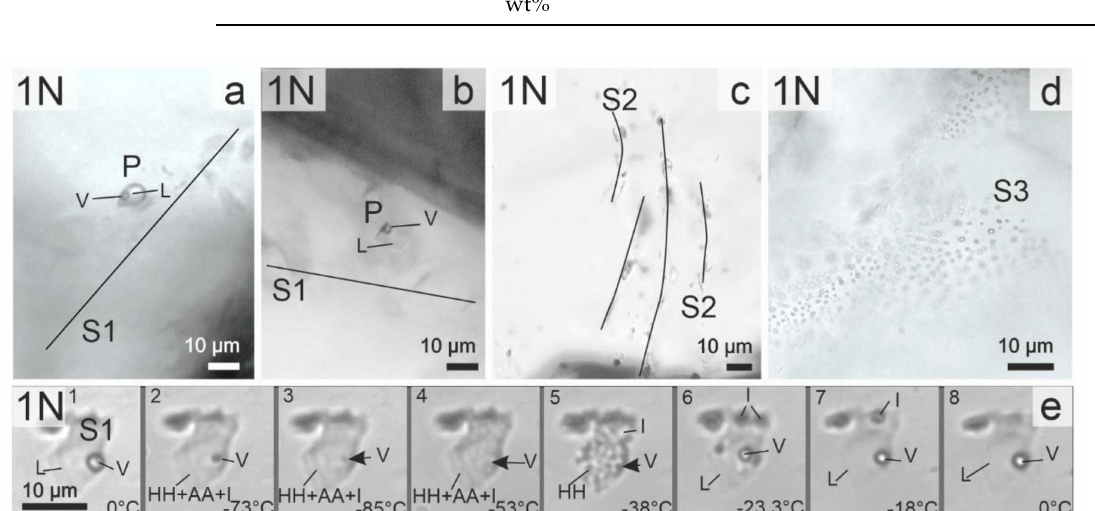
Figure 4. Fluid inclusions in fluorite. ( a ) Two-phased P inclusion near an S1 inclusion plane; ( b ) two-phased P inclusion close to a grain boundary near an S1 inclusion plane; ( c ) S2 two-phased inclusion generation; ( d ) one-phased S3 inclusion generation; ( e ) the behavior of an S1 inclusion during freezing. Abbreviations used: P, primary inclusion; S, secondary inclusion; L, liquid phase; V, vapor phase; HH, hydrohalite (NaCl · 2H 2 O); AA, antarticite (CaCl 2 · 6H 2 O); I,